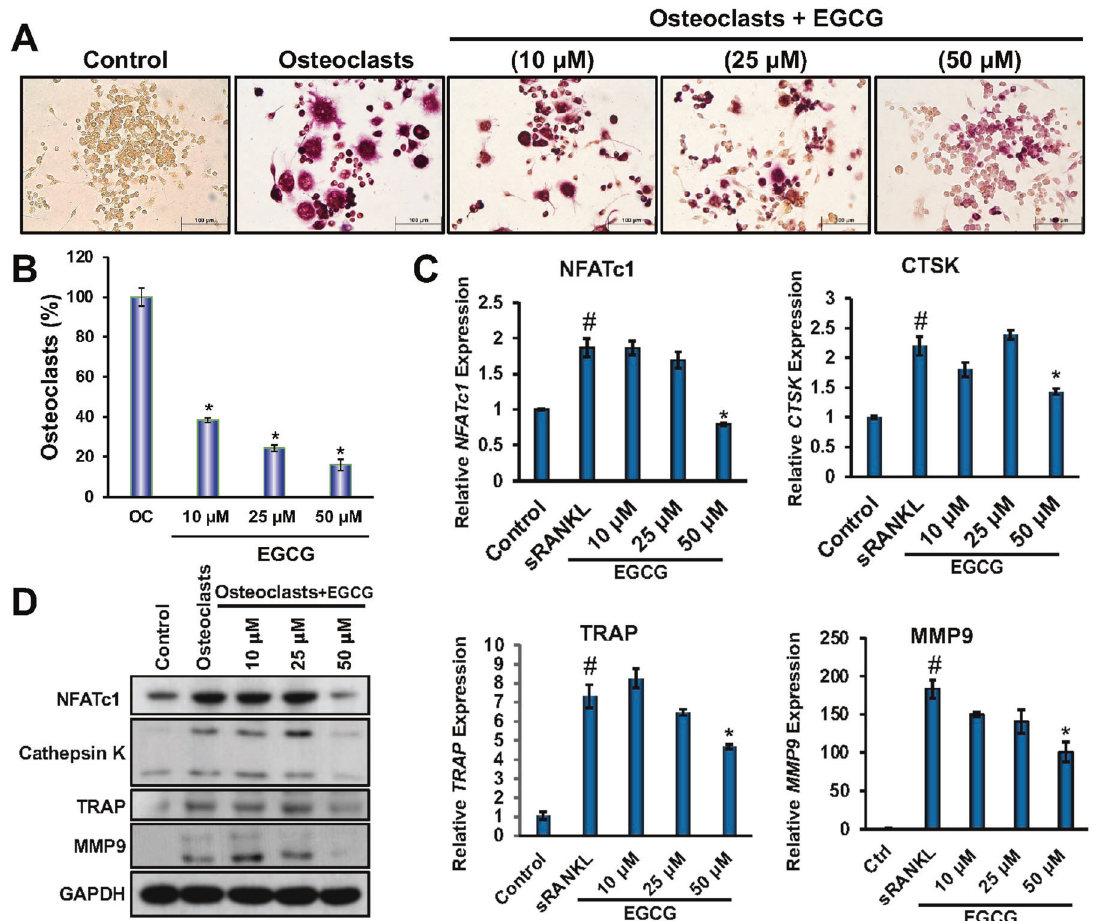
Fig. 1 Dose-dependent inhibition of OC differentiation, along with its related molecules both in mRNA and protein levels by EGCG. A TRAP staining of OC differentiated cells in the presence or absence of EGCG. The dark purple color indicates the differentiated cells. B The percentage of TRAP-positive multinucleated OCs in each group is shown graphically. C Quantitative real-time PCR analysis for the expression of NFATc1, CTSK, TRAP, and MMP9 during OC differentiation. D Western blot for protein expression of NFATc1, cathepsin K, TRAP, and MMP9 molecules. For qRT-PCR β -actin, and for western blot GAPDH was used as a loading control. Results are mean ± SEM ( n = 3). (#), p < 0.05 compared with basal condition; and (*), p < 0.05 compared with induced OC differentiated